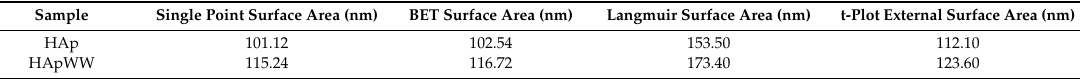
Table 2. Parameters of nitrogen adsorption / desorption isotherms of HAp and HApWW samples.